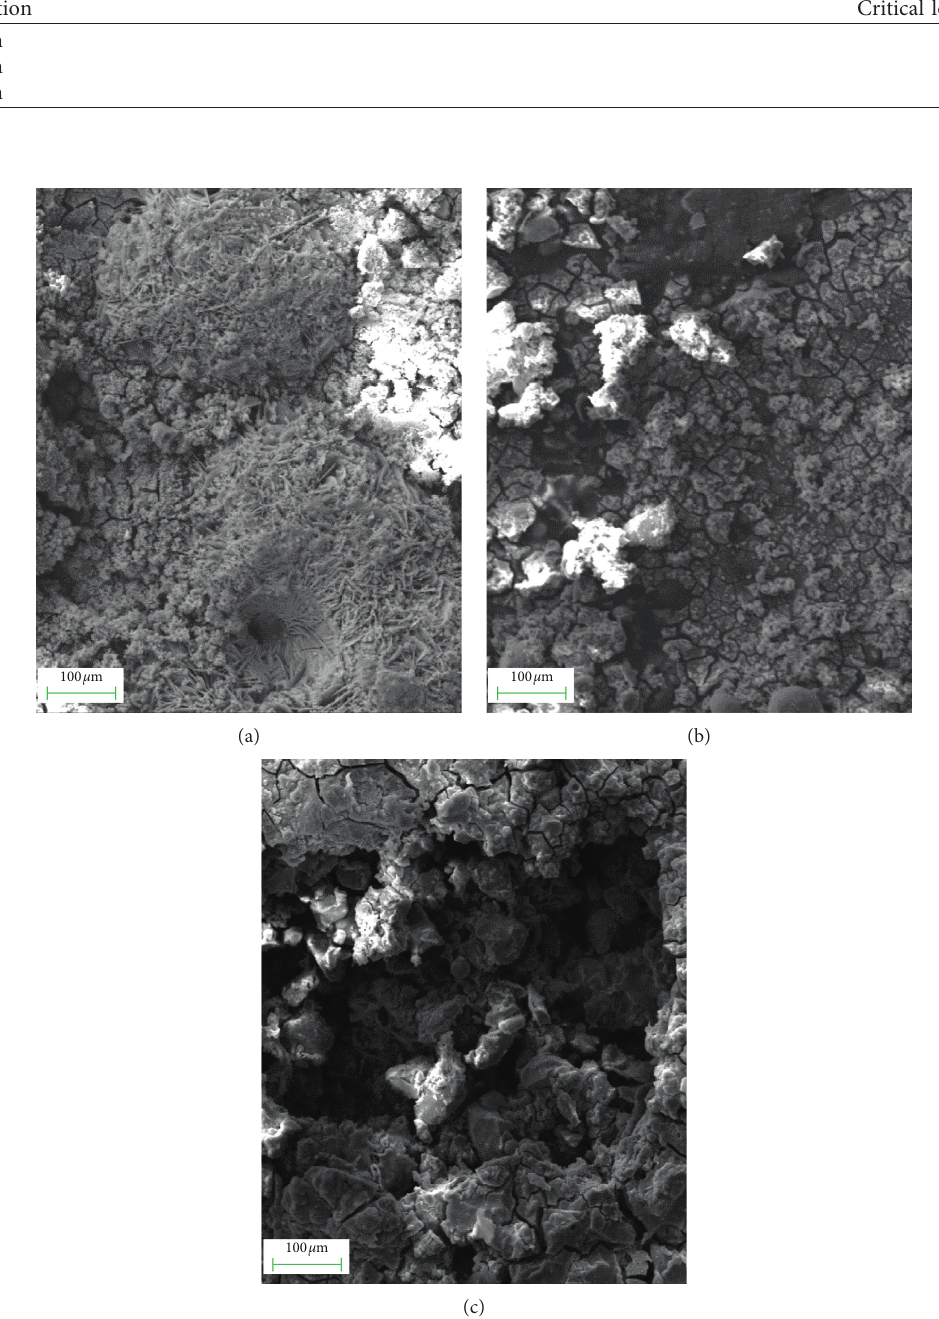
Figure 9: SEM diagram of surface morphology of coating after corrosion: (a) 40% Al-60% Zn, (b) 30% Al-70% Zn, and (c) 20% Al-80%